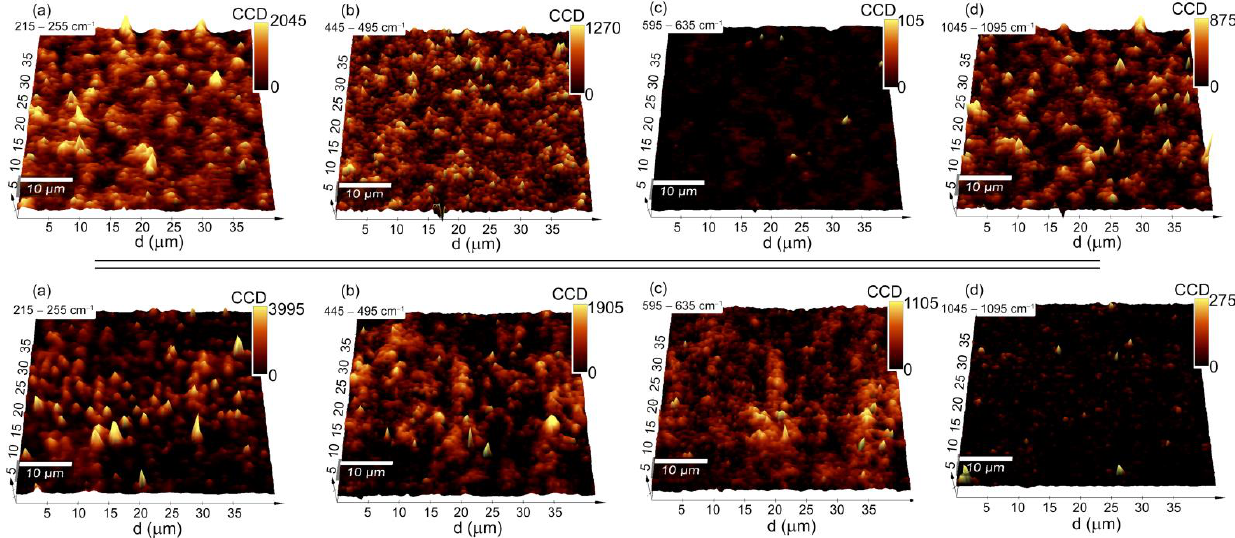
Figure 4. 3D Raman imaging maps of the pristine Ag-SiO 2 /TiO 2 /NiTi composite ( upper panels ) and the composite that was sintered at 700 ◦ C ( lower panels ) that were obtained as a result of the integrated intensity analysis considering the bands that were assigned to ( a ) Ag-O; ( b ) SiO 2 ; ( c ) Si-O-Ti; and ( d ) Ag 2 CO 3 .